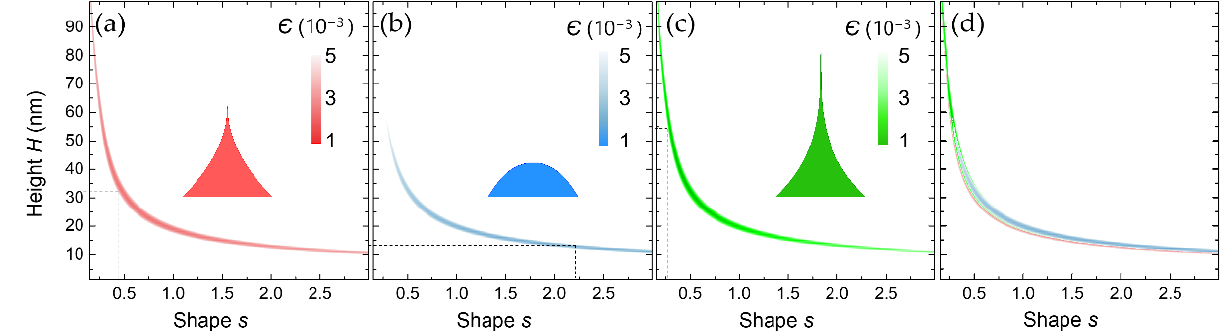
Figure 7. Free fit results of the NLEM model assuming both height H and shape s as free parameters. In these threshold images, color-coded is the error function. The white space represents ( H , s ) points for which the error is higher than 5 × 10 −3 . The dashed lines point to the FDTD system they try to fit: ( a ) H = 32 nm, s = 0.5, ( b ) H = 12 nm, s = 2.27, ( c ) H = 54 nm, s = 0.28. A continuous band of small errors traces through optically similar combinations of roughness height and shape. This is proved in ( d ), where the overlayed error lines fall almost perfectly on each other.